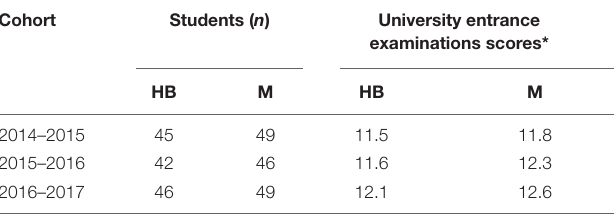
TABLE 2 | Academic characteristics of the students in the PBL-courses. *Maximum score was 14.